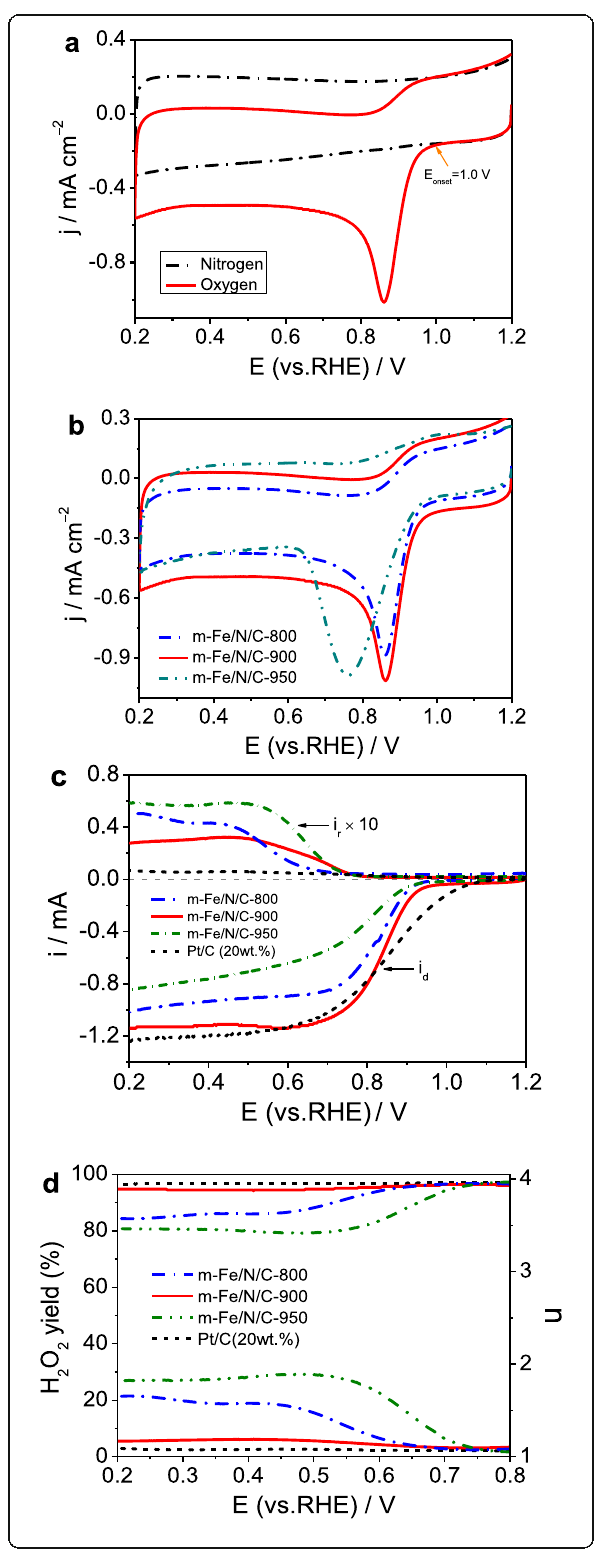
Fig. 8 a CV curves of m -Fe/N/C-900 in N 2 vs O 2 -saturated 0.1 M KOH solution. b CV curves of m -Fe/N/C-800, m -Fe/N/C-900, and m -Fe/N/ C-950 in O 2 -saturated 0.1 mol l -1 KOH solution. c Disk and ring currents obtained with LSVs on RRDE for m -Fe/N/C-800, m -Fe/N/C- 900, and m -Fe/N/C-950 in O 2 -saturated 0.1 mol l -1 KOH solution. d The corresponding electron transfer numbers and H 2 O 2 yields of m - Fe/N/C-800, m -Fe/N/C-900, and m -Fe/N/C-950 derived from